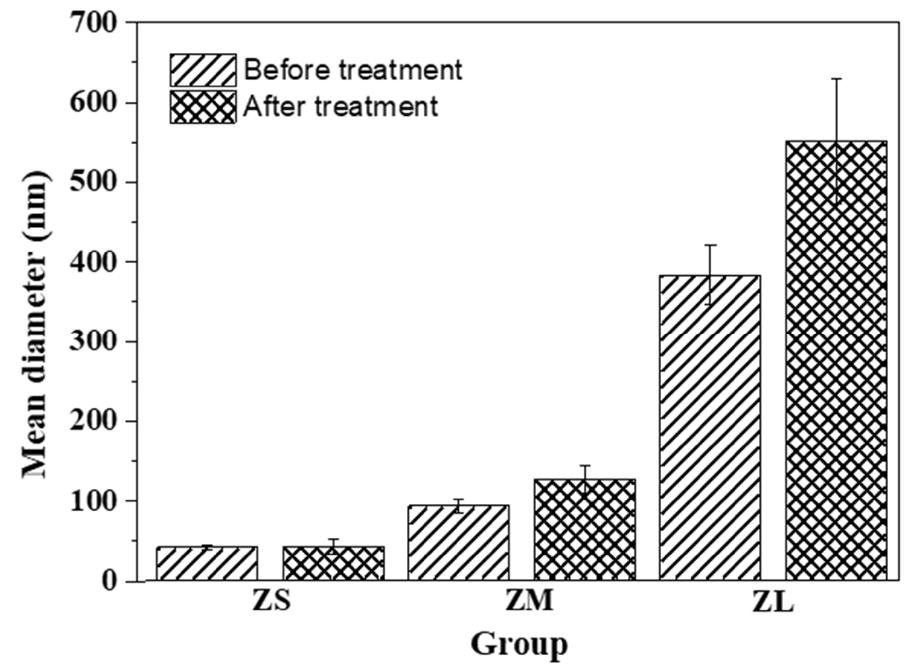
Figure 3. Size distribution of zirconia particles before and after silane coating.